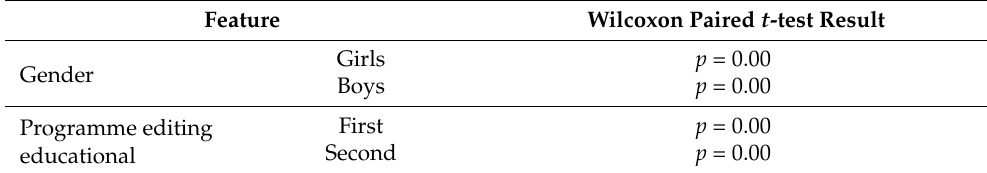
Table 6. Results of a statistical test assessing the difference between the percentage of correct answers before and after the educational